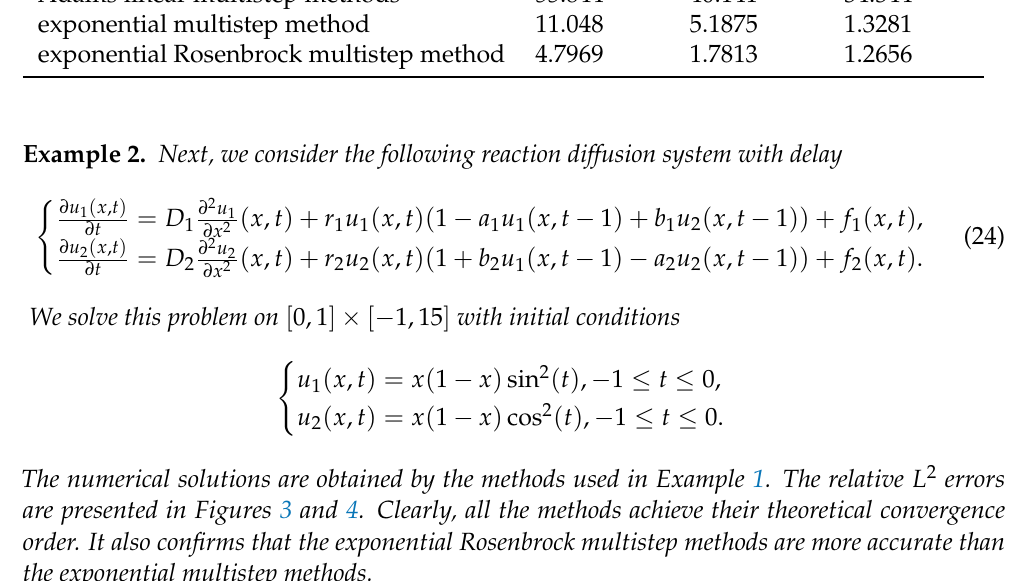
Table 1. CPU times of all the methods achieving error tolerance 10 − 8 for problem (23). k = 2 k = 3 k =